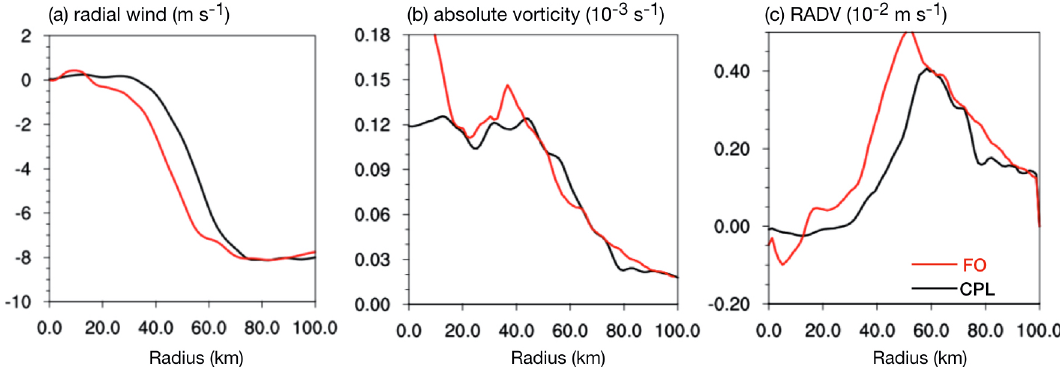
Figure 14. The azimuthally averaged ( a ) radial wind (negative denotes the inflow, unit: m s − 1 ), ( b ) absolute vorticity (10 − 3 s − 1 ) and ( c ) radial advection of the absolute vorticity (RADV) term in Equation (2). The averaged period is from 1300 UTC to 1700 UTC on 22